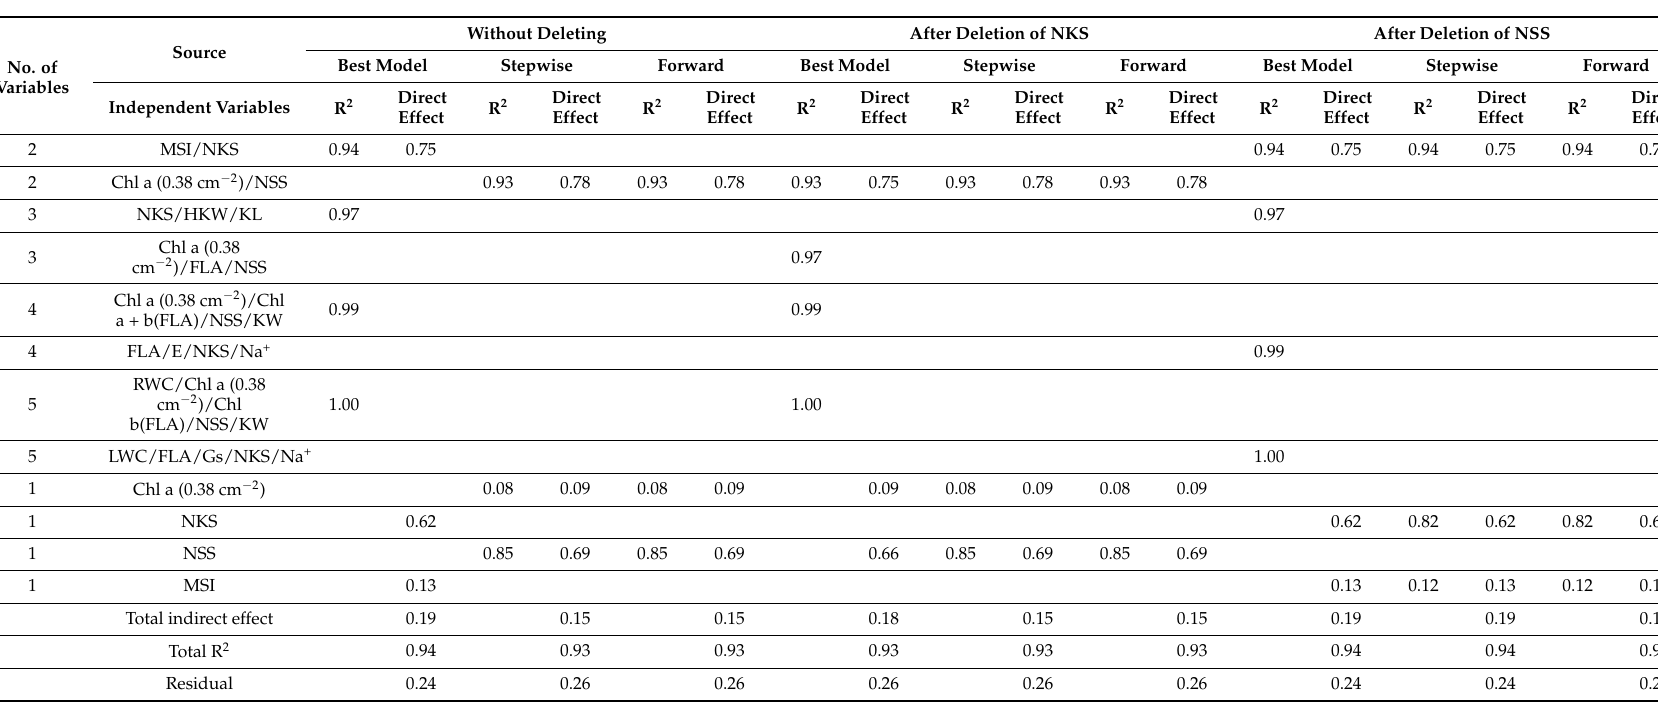
Table 1. Summary of multiple linear regression analysis (best model, stepwise, and forward) and path analysis (direct and indirect effects) for grain yield (dependent variable) with 28 yield-related traits (independent variables) for nine